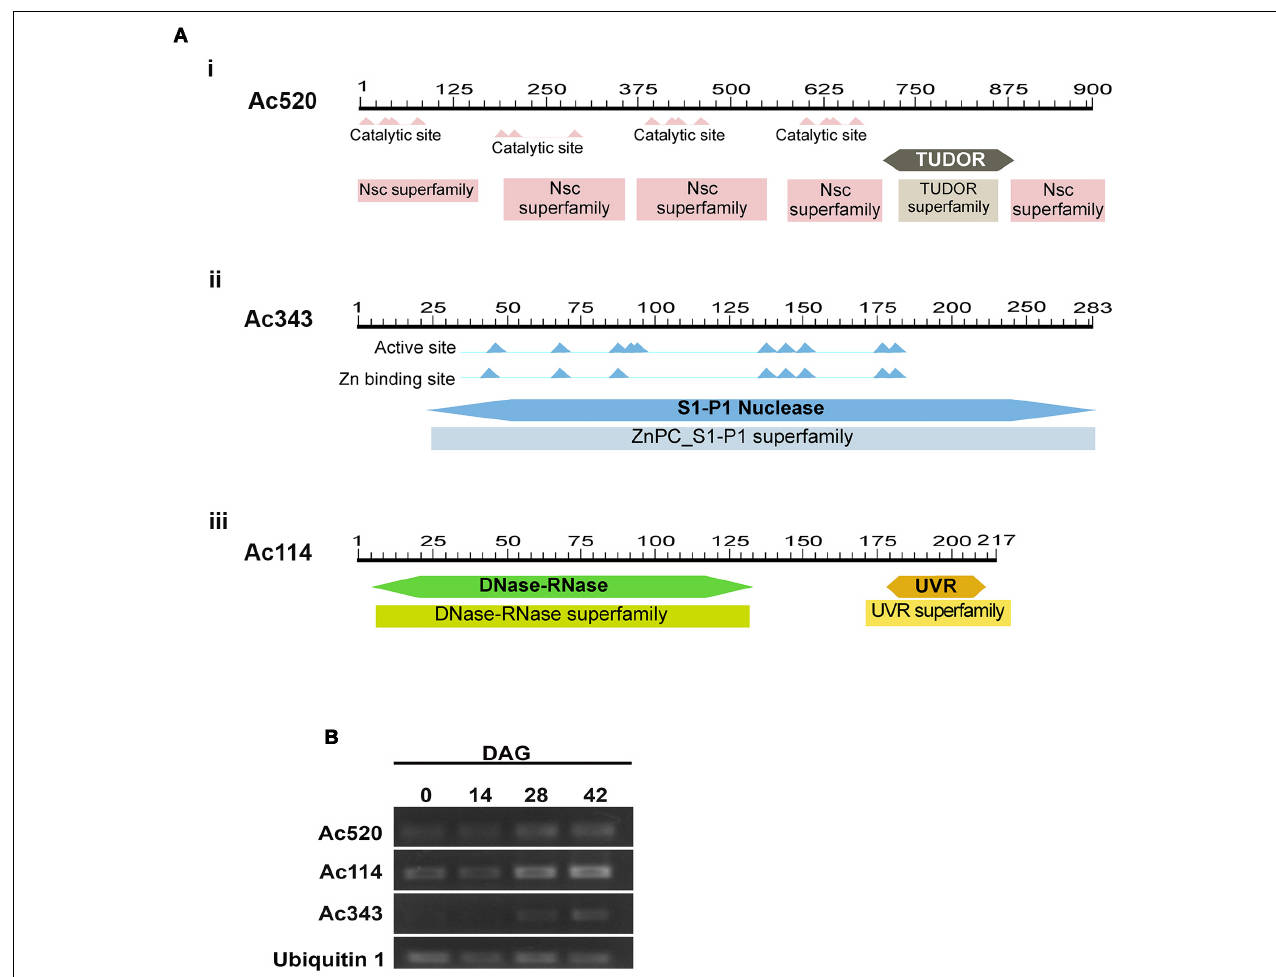
FIGURE 5 | (A) In silico analysis of putative nuclease in Araucaria angustifolia. (i) . Representation of the Ac520 protein showing the Staphylococcal nuclease domains at the N terminus and a Tudor domain toward the C terminus. (ii) Representation of the Ac343 protein showing the S1-P1 Nuclease domain. (iii) Representation of the Ac114 protein showing the DNase-Rnase domain. (B) Expression levels of the putative nuclease genes during the germination process in A. angustifolia . Amplified products of the Ac520, Ac114, and Ac343 genes by semiquantitative RT-PCR. As a control for constitutive expression, a fragment of the Ubiquitin 1 gene was simultaneously amplified. The results are representative of at least three independent biological